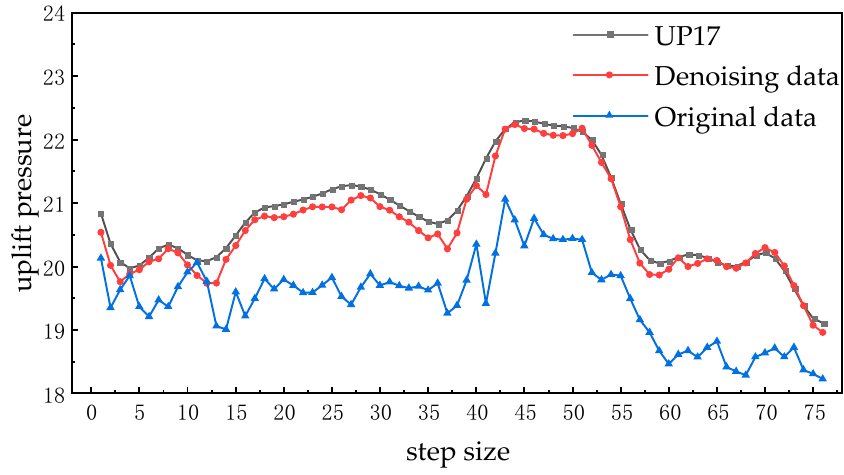
Figure 10. Prediction curves for the original and denoised data of UP17 measurement points.